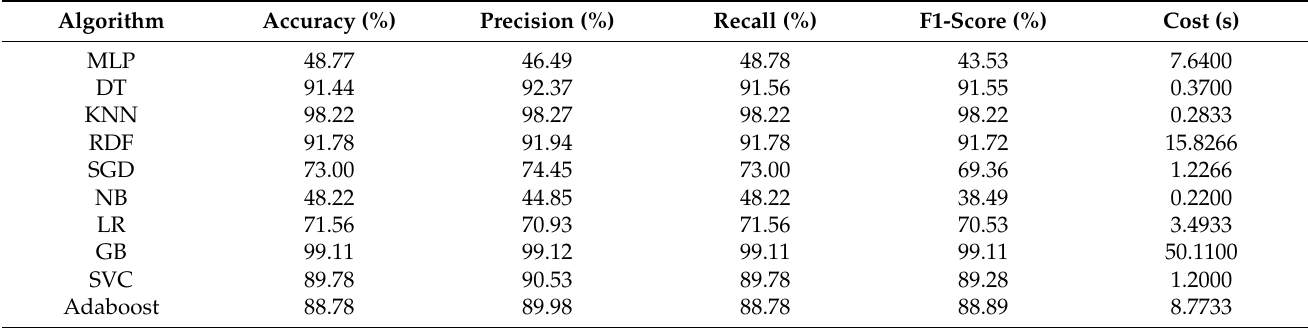
Table 6. Global performance comparison of ML models using impedance (Z) features.